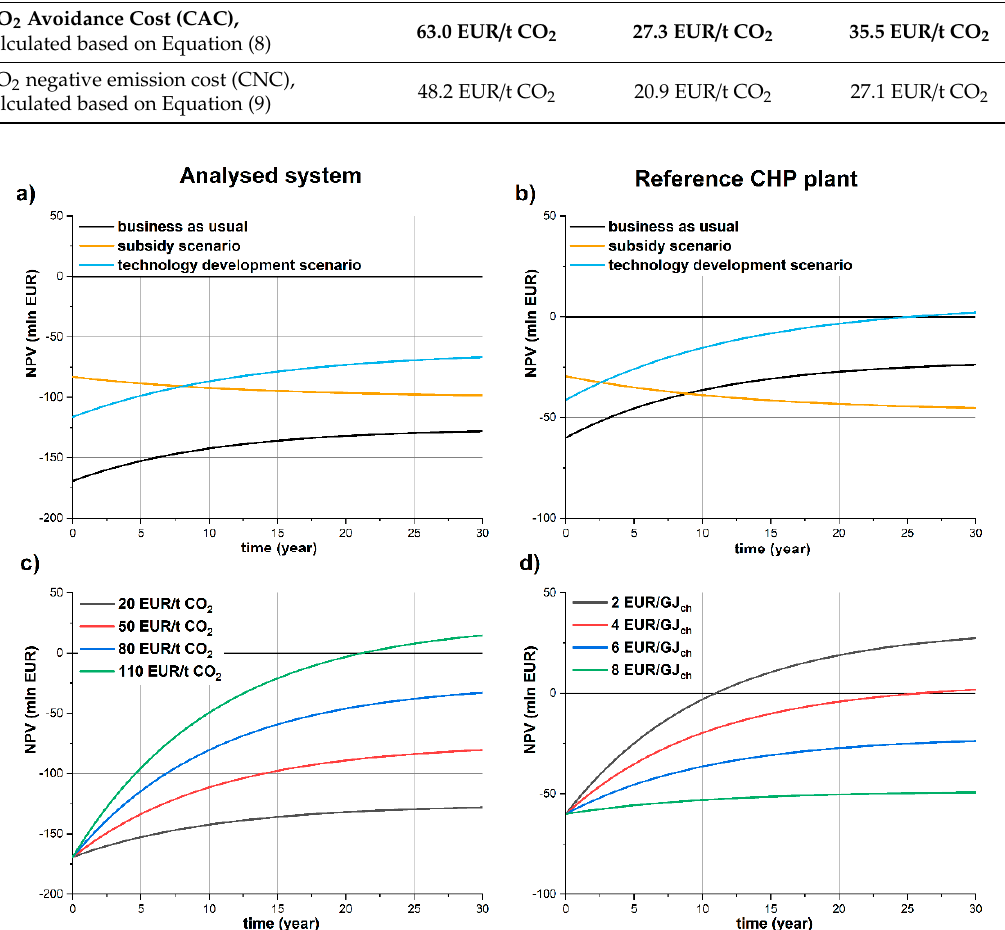
Figure 11. The Net Present Value (NPV) for different scenarios in ( a ) the analyzed system and ( b ) the reference biomass-fired CHP plant, and for the business as usual scenario impact of different ( c ) negative CO 2 emission credits in the analyzed system and ( d ) prices of fuel in the reference biomass-fired CHP plant. Table 7. Summary of the economic assessment.